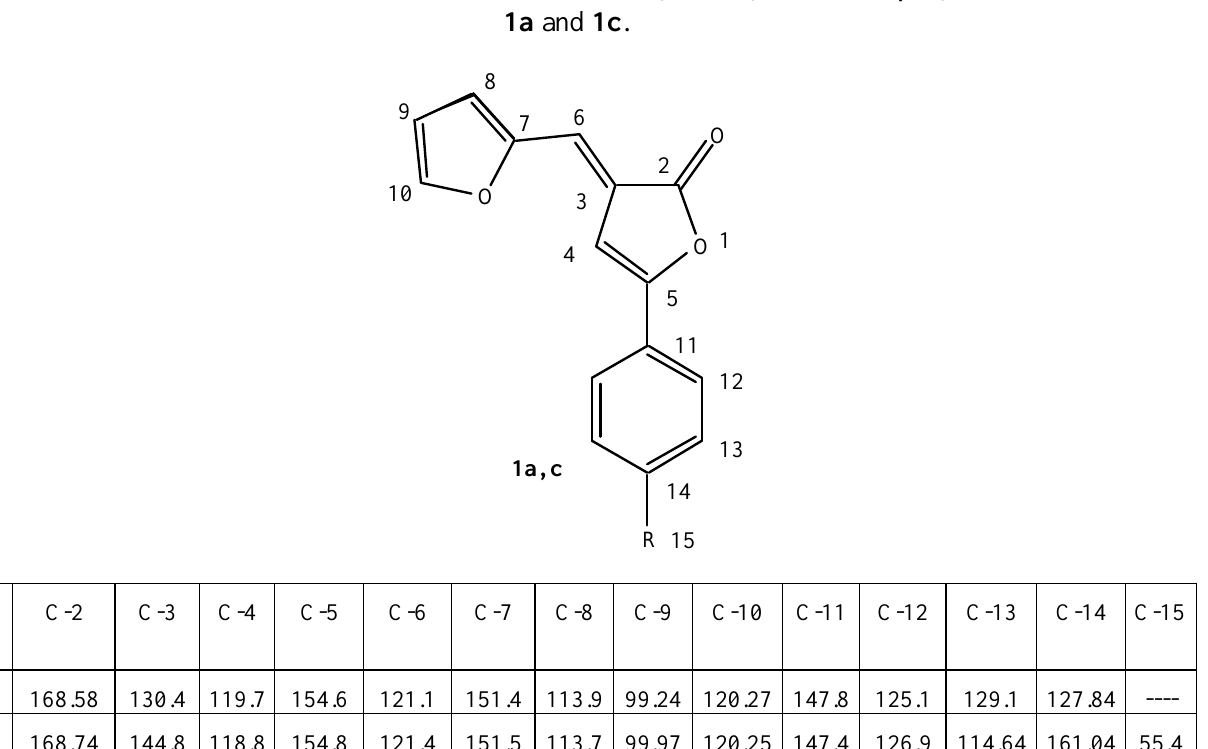
Table 4. 13 C Chemical shifts ( d C[ 2 H